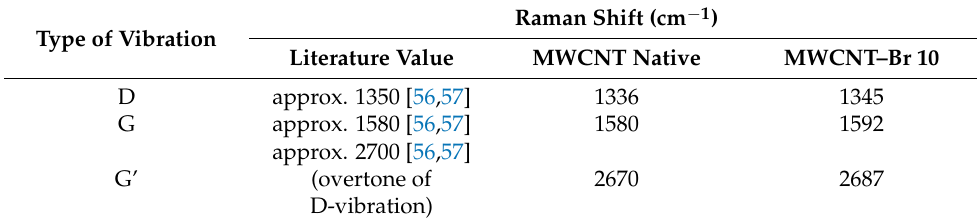
Figure 8. Raman spectra for native MWCNT and MWCNT–Br 10. Table 5. Raman shift for MWCNT before and after the 10 days